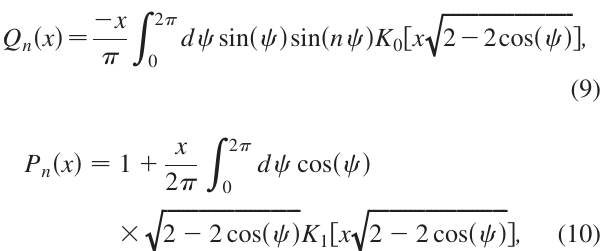
FIG. 1. Diagram of azimuthal B